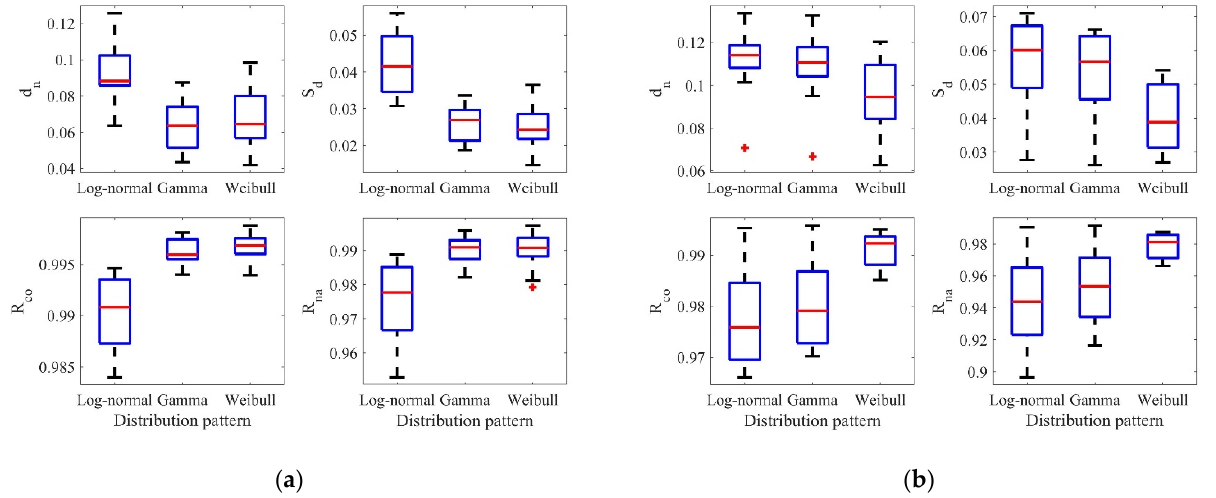
Figure 3. Boxplots of the goodness-of-fit for the runoff and water levels (S d is the standard deviation, R co is the Pearson correlation coefficient, and R na is the Nash coefficient between the observed values and the simulated values). ( a ) Wangkuai Reservoir runoff, ( b ) Water level of Lake Baiyangdian.